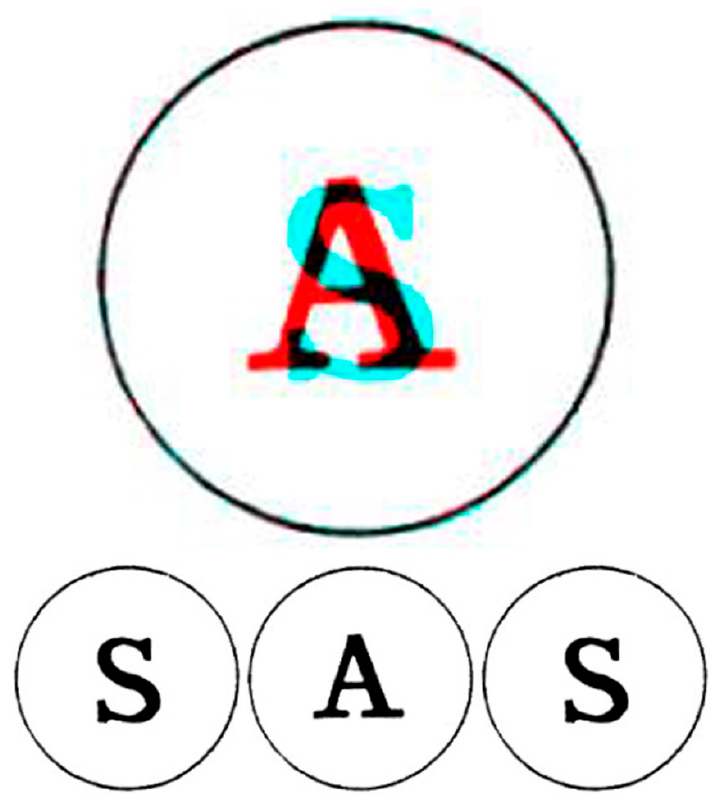
Figure 1. Rivalry between the letters S and A (from [3]). Upper: an anaglyph in which the rivalry can be seen with red / cyan glasses. Lower: left eye, right eye and left eye members of the binocular pairs presented in Universal Freeview format. There are two ways to superimpose the two rivalling letters: to cross-fuse the right pair, or to uncross-fuse the left pair.